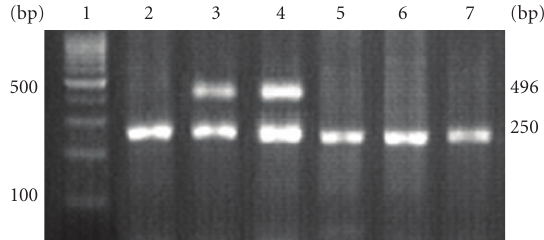
Figure 3: RT-PCR analysis of TSP1 in tumor tissues. 1:100 bp DNA marker; 2,5,6,7: negative mRNA expression; 3,4: positive mRNA expression. Table 3: Methylation status of TSP1 and protein expression of TGF- β 1 in GCA patients. TSP1 methylation status TGF- β 1 protein expression Hypermethylation Unmethylation 24